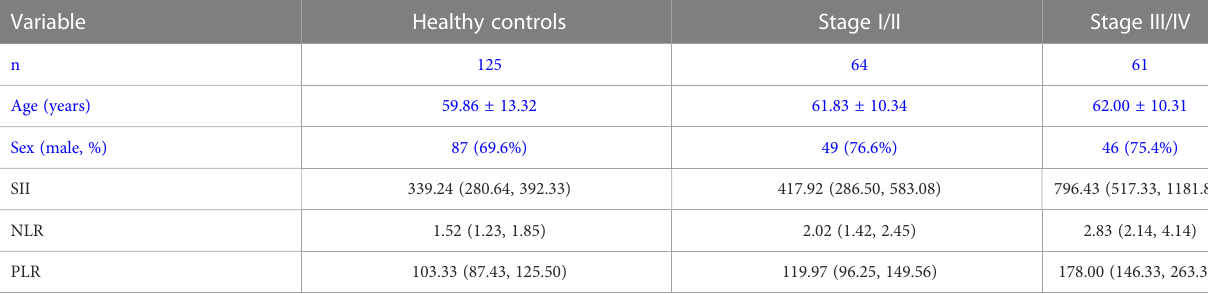
TABLE 3 Systemic in fl ammation laboratory values for various TNM staging.